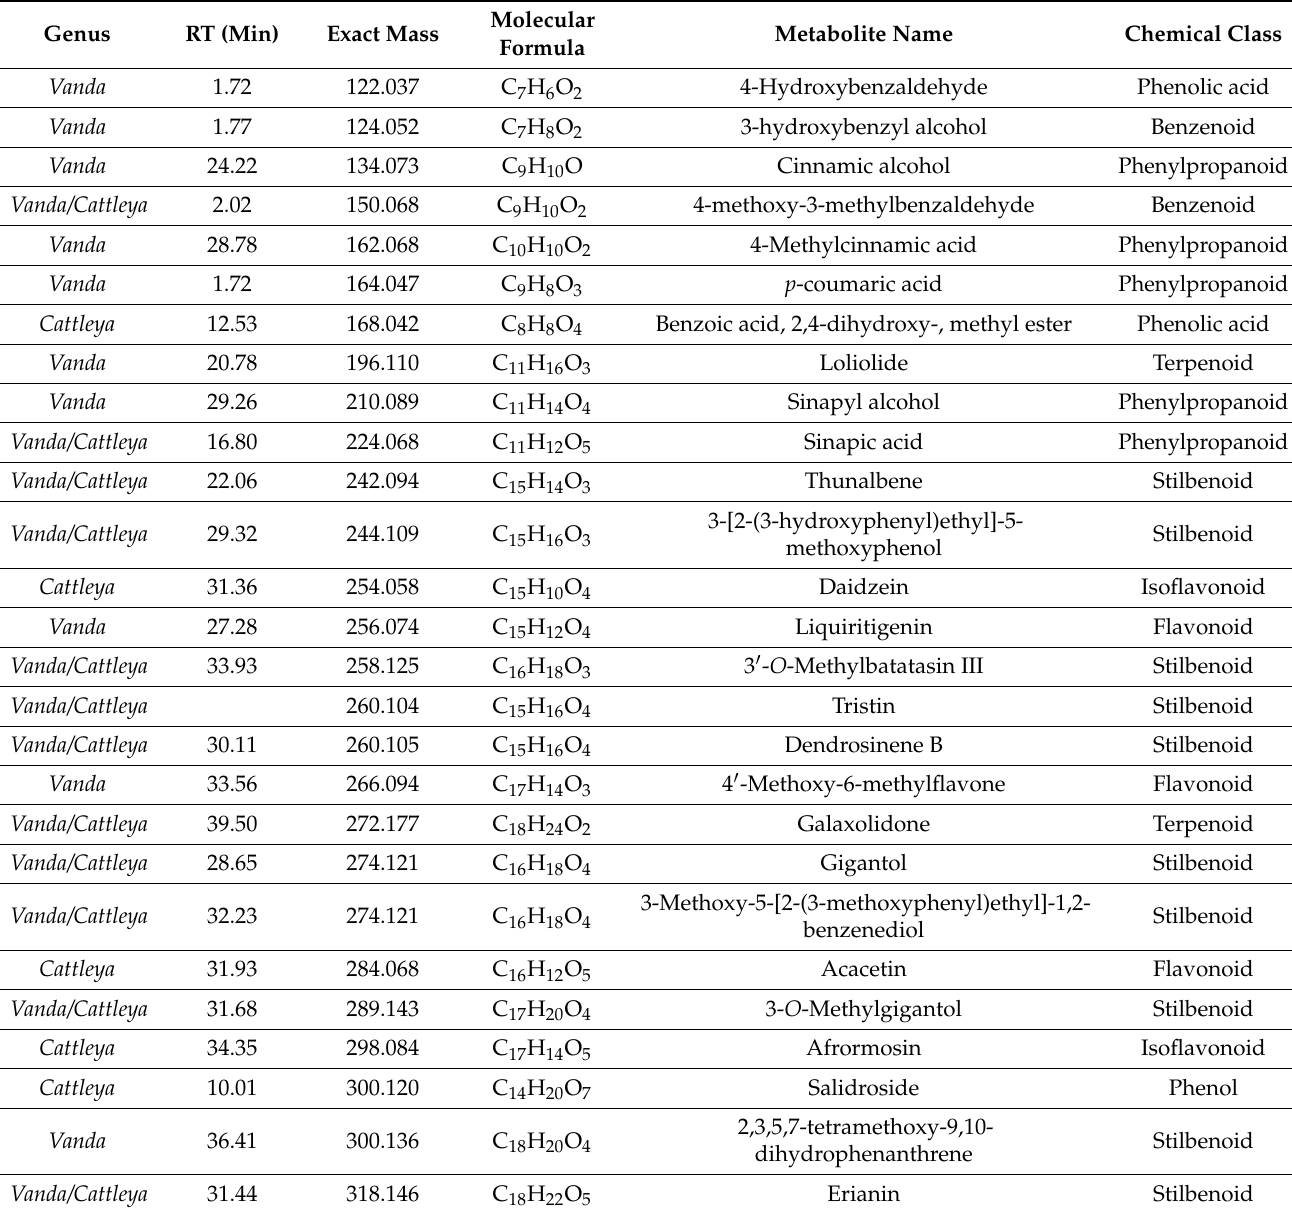
Table 1. Results of the metabolite annotation from Orchidaceae species ( Vanda and Cattleya ) through LC-HRMS/MS analysis in positive ion mode